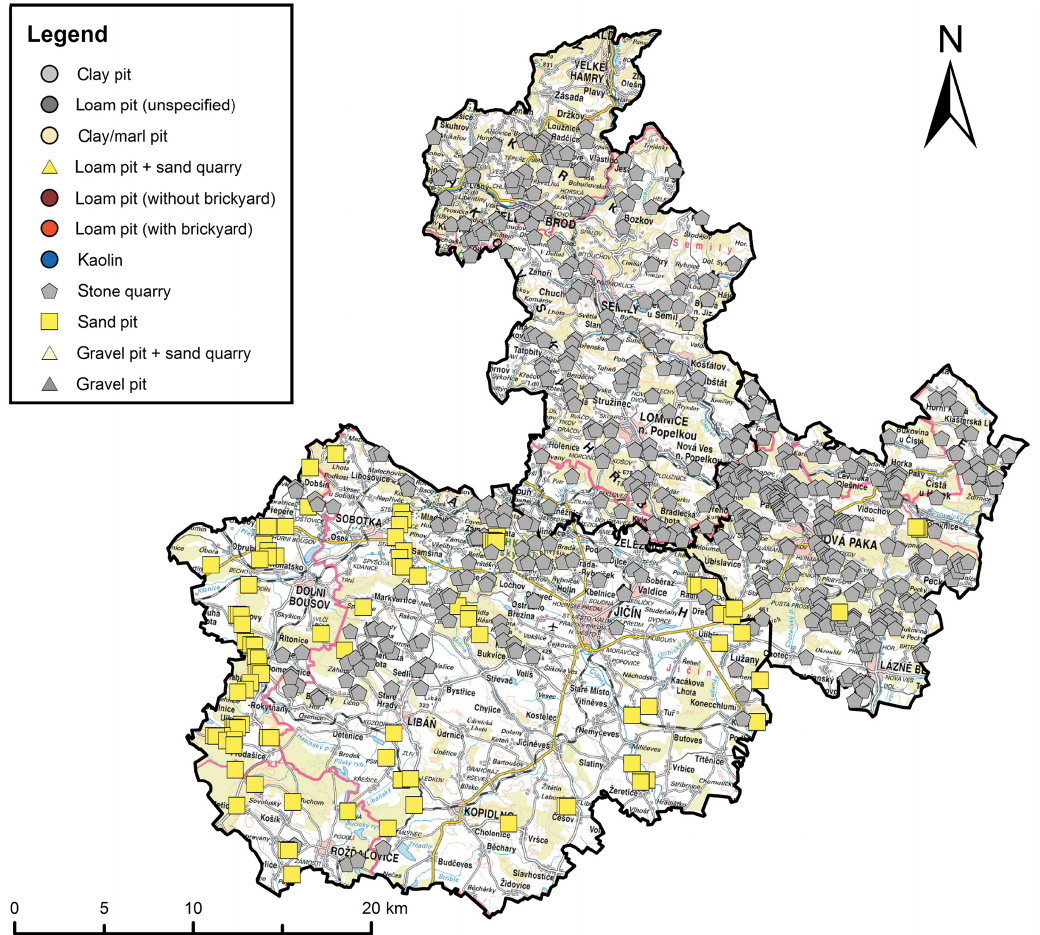
Figure 2. Example of the mining site distribution in three districts (top: Semily; right: Nová Paka; bottom: Jiˇcín).